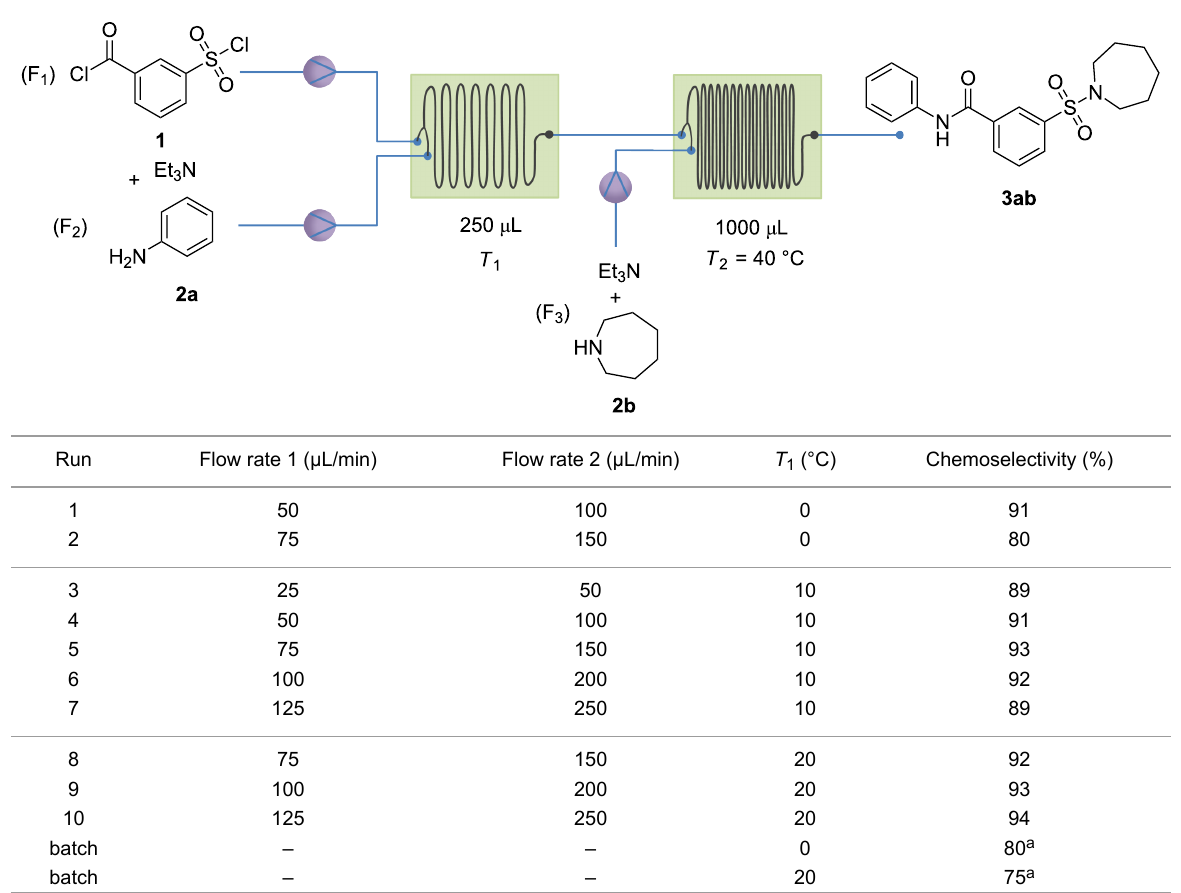
Table 1: Screening results of the different conditions for the best chemoselectivity with aniline and azepane as (F 2 ) and (F 3 ), respectively.